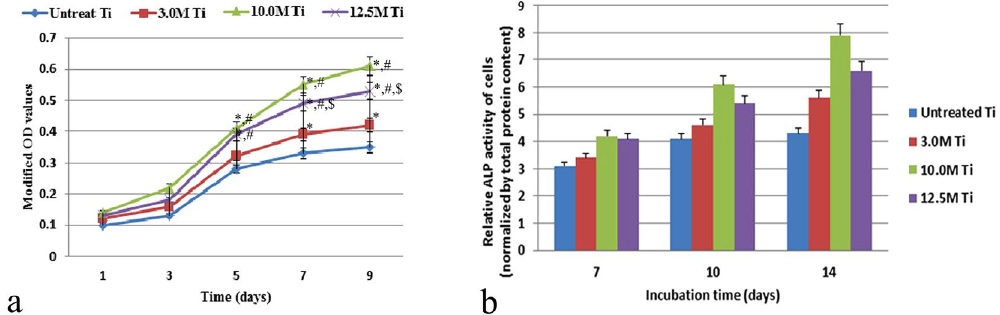
Figure 8. In vitro cell behaviours on the PT, T-3, T-10, and T-12.5 samples: ( a ) cell viability; ( b ) ALP activity. * p < 0.05 vs PT, $ p < 0.05 vs T-3, # p < 0.05 vs T-10.